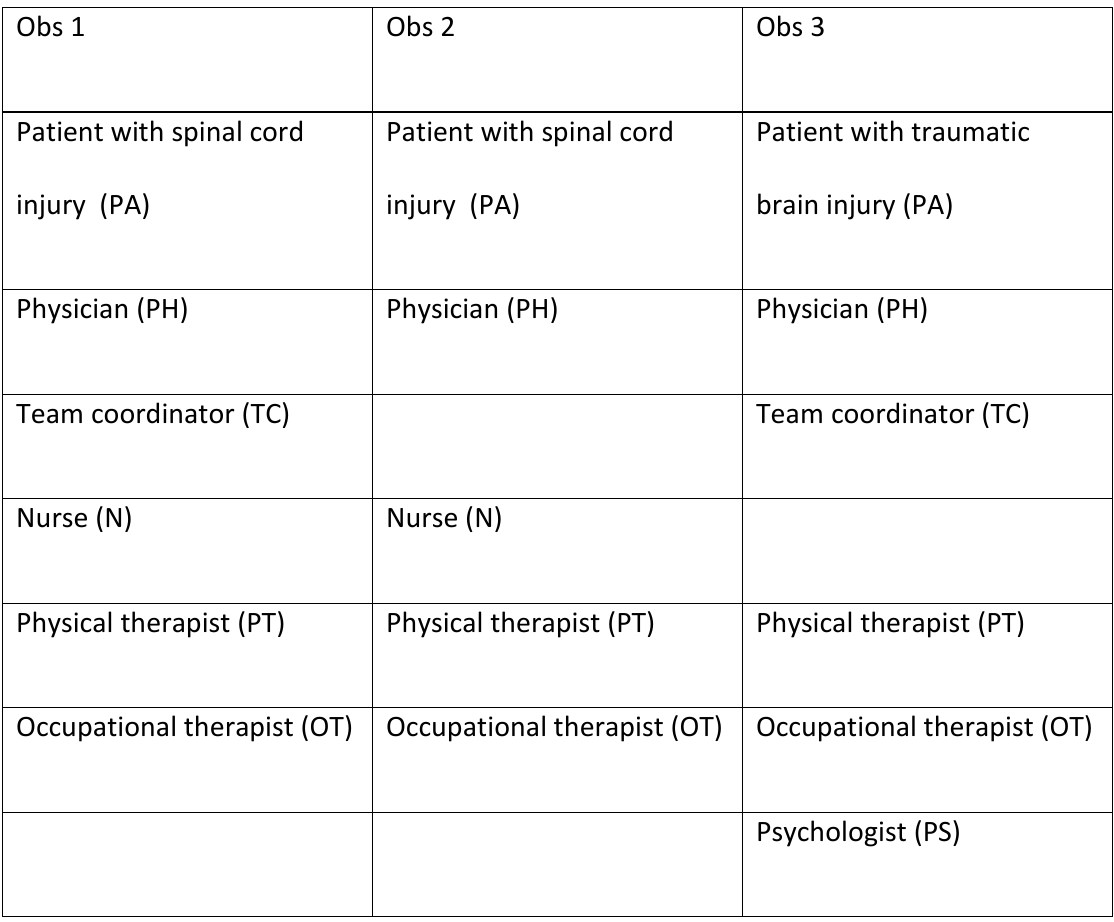
Table 1. Participants in the observed team